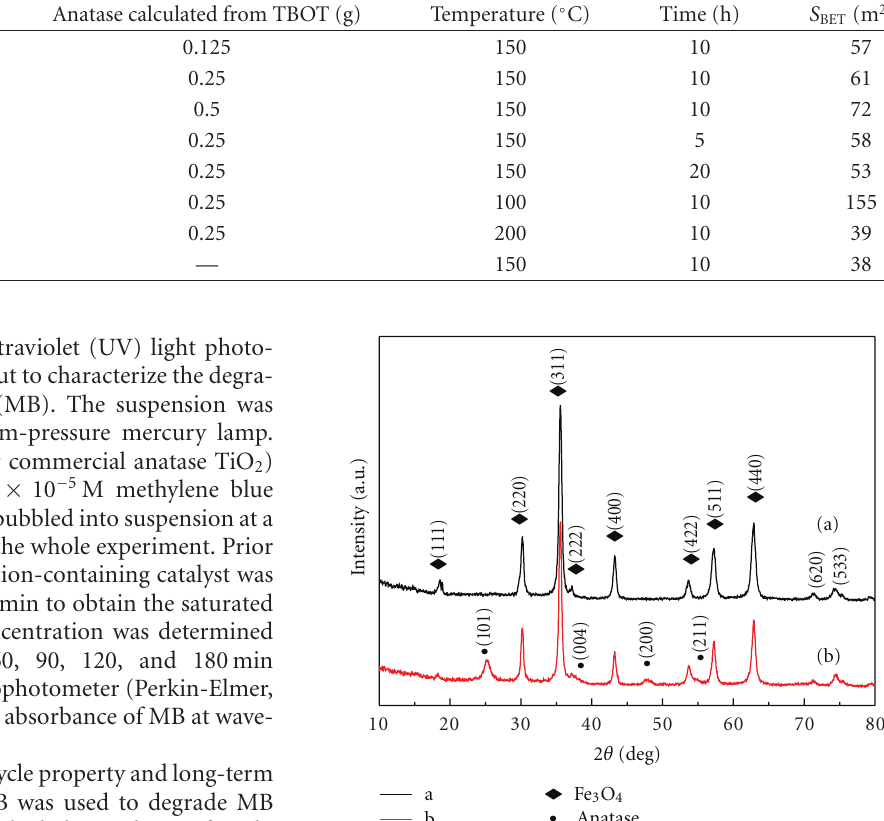
in Figure 3(a) and connect tightly to one another to form spheres. And the diameter of the aggregated particles is around 200 nm (Figure 4(a)). Figure 3(b) shows that amor- phous carbon and well-crystallized anatase TiO 2 formed on the surface of Fe 3 O 4 microspheres, and the amorphous car- bon shell is compact while polycrystalline titania shell is around the carbon shell. The carbon content in the Fe 3 O 4 /C nanocomposites and Sample B is measured to be 4.4 wt.% and 2.8 wt.%. The crystallite sizes of Fe 3 O 4 and anatase TiO 2 are around 15 and 12 nm, which is in agreement with the calculation of XRD. The distances marked in the pattern (Figure 3(c)) between (101) plane of anatase and (311) plane of Fe 3 O 4 are 0.35 nm and 0.25 nm, respectively. A well-de- fined core/multishell structure with Fe 3 O 4 as core,